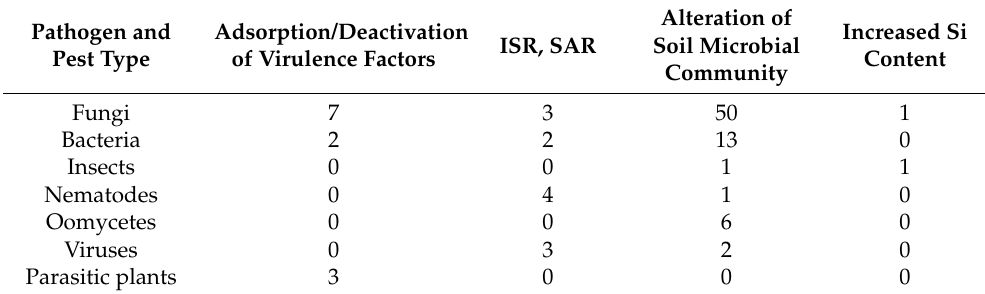
Table 1. Count of case studies reporting different putative causal mechanisms by which biochar induces disease suppression or pest